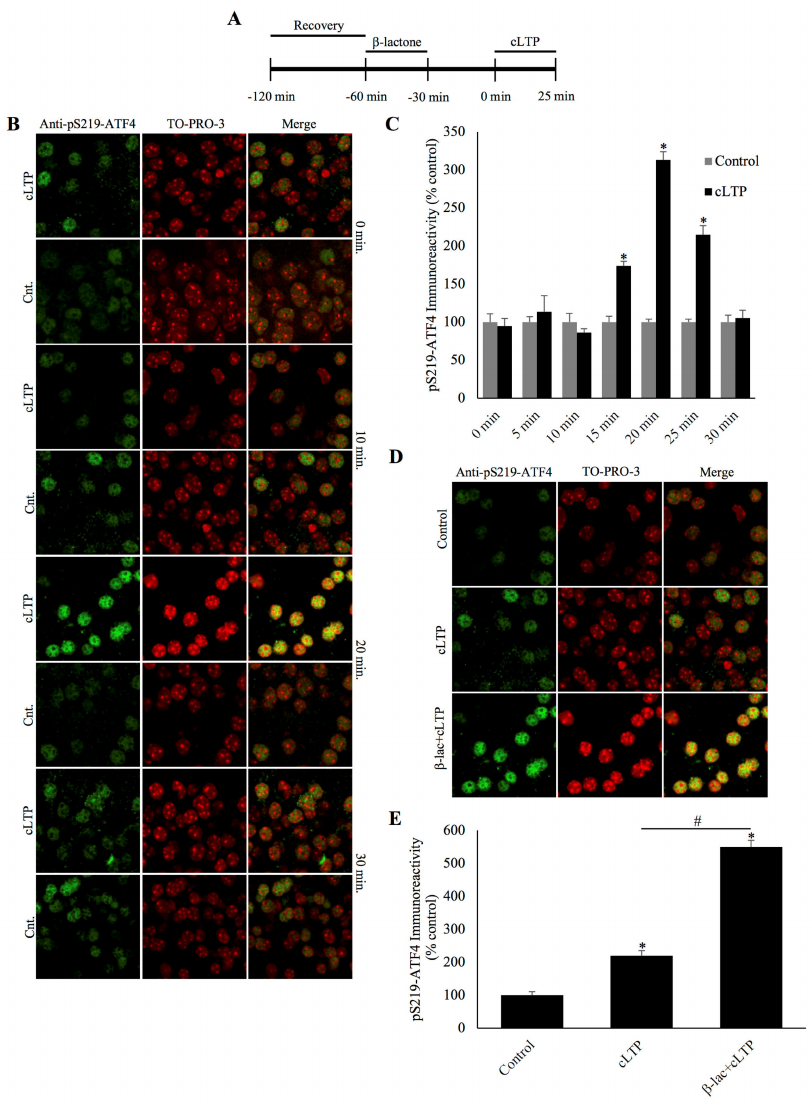
Figure1. Phosphorylatedactivatingtranscriptionfactor4(ATF4)isdegradedduringchemicallyinduced long-term potentiation and the degradation can be blocked by a specific proteasome inhibitor β